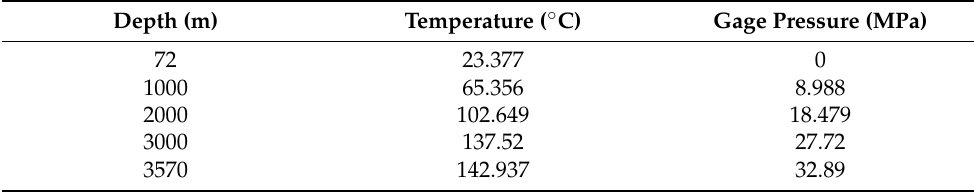
Table 5. Static temperature and pressure in the tested well.